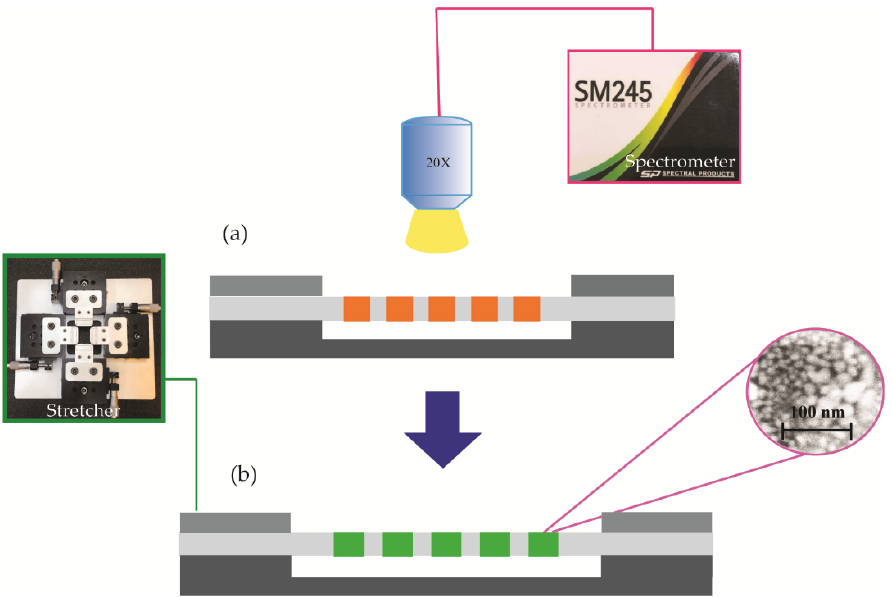
Figure 6. Schematic of the characterization setup for the thin film (a flexible PDMS membrane) with Ag nanoislands embedded, ( a ) before and ( b ) after stretching the PDMS film. Inset, SEM image of the dewetted Ag nanoislands.